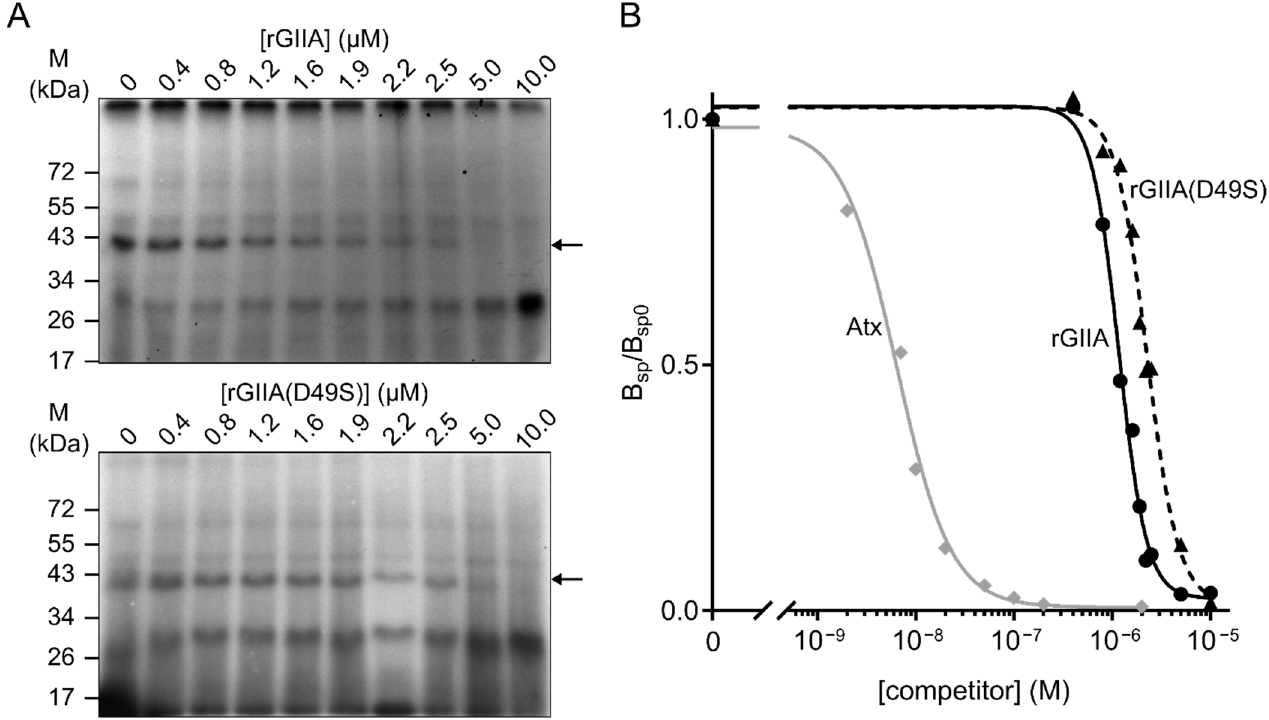
Figure 1. Heterologous competition assay revealed that rGIIA and its enzymatically inactive mutant rGIIA(D49S) inhibit 125 I-Atx binding to its mitochondrial binding protein, CCOX-II. ( A ) Autoradiogram of the SDS-PAGE gel of detergent extracts of porcine cerebral cortex demyelinated P2 fraction labeled with 125 I-Atx in the presence of the indicated concentrations of unlabeled sPLA 2 s, rGIIA or rGIIA(D49S). The unlabeled sPLA 2 s inhibited the formation of the specific adduct with an apparent molecular mass of 39 kDa (black arrows). ( B ) Dose–response curve relating the extent of cross-linking of 125 I-Atx with the 25 kDa receptor to the concentration of unlabeled sPLA 2 s present during the incubation. The data were obtained by quantifying the intensity of the specific 125 I-Atx adduct from the autoradiograms in ( A ).